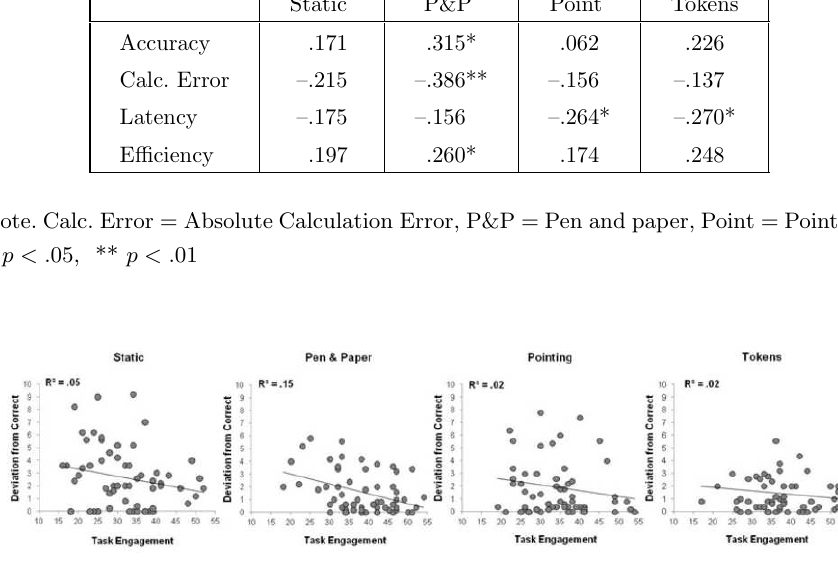
Figure 4. Scatterplots of task engagement scores and mean absolute deviation errors in the four experimental conditions. The slope of the linear trend in all four conditions was negative, but only significantly so in the pen and paper condition, r (58) = –.386, p =